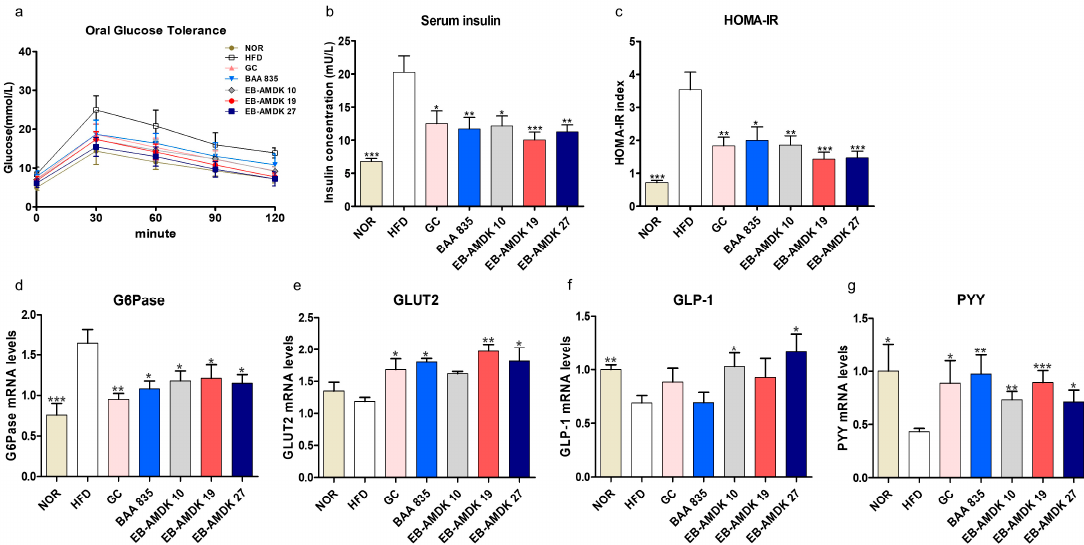
Figure 3. A. muciniphila strains improved insulin sensitivity and glucose homeostasis in HFD-induced obese mice. ( a ) Serum glucose levels at different time-points in oral glucose tolerance tests (OGTT). ( b ) Serum insulin level and ( c ) HOMA-IR. mRNA levels of glucose homeostasis ( d ) G6Pase and ( e ) GLUT2 in the hepatic of each group ( n = 9–12 mice / group). mRNA expression of related markers of gut hormones ( f ) GLP-1 and ( g ) PYY were measured in the intestinal tissue ( n = 9–12 mice / group). The data are represented as the mean ± SEM. Statistics were performed with one-way ANOVA or Student’s t-test. * p < 0.05, ** p < 0.01 and *** p < 0.001 versus the HFD